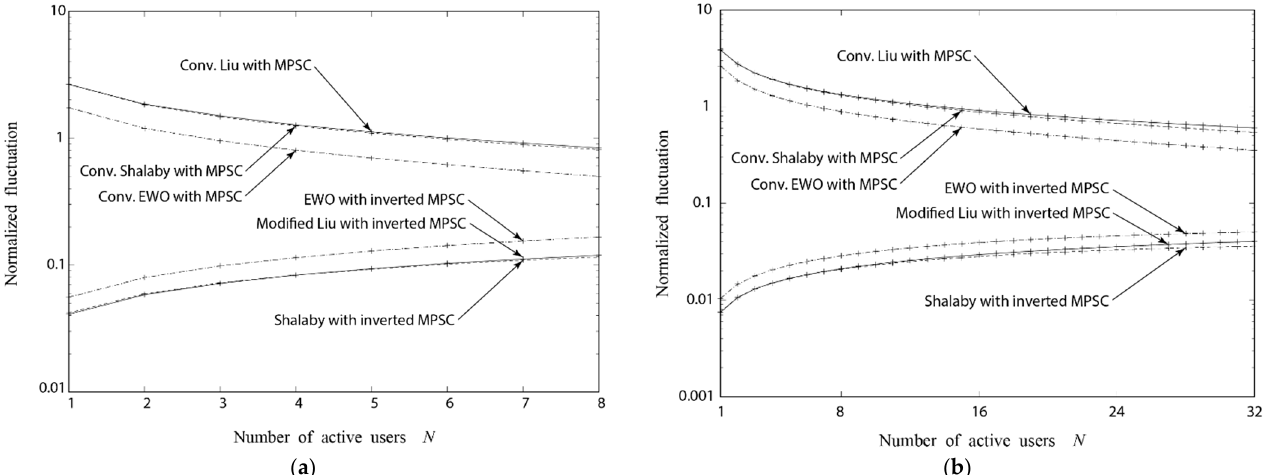
Figure 6. Comparisons of normalized fluctuation. ( a ) 𝑞 = 4, 𝑁 (cid:2896) = 8, and 1 ≤ 𝑁 ≤ 8, ( b ) 𝑞 = 8, 𝑁 (cid:2896) = 32, and 1 ≤ 𝑁 ≤ 32.